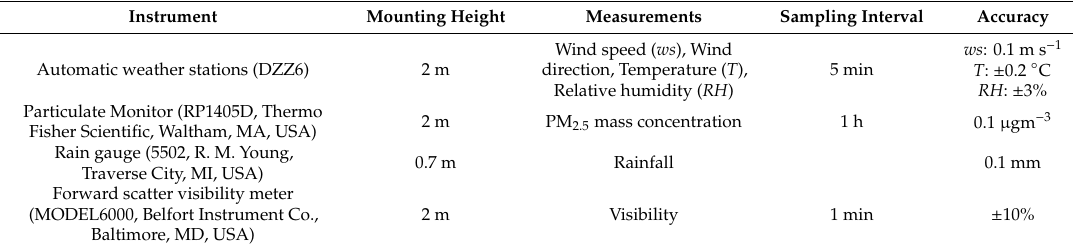
Table 1. List of instruments at automatic weather stations (AWS).